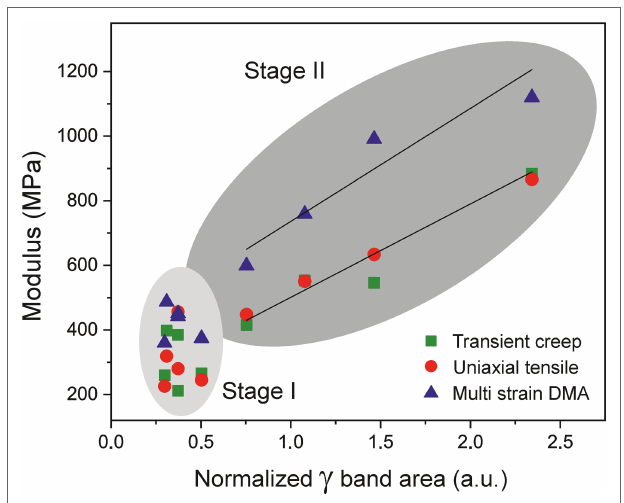
FIGURE 9 | Evolution of Young’s (squares and circles) and storage (triangles) moduli vs. the normalized area of gamma band (phenolics) of cuticles along fruit development. The modulus is correlated with the phenolic content in the 35–55 daa period (Stage